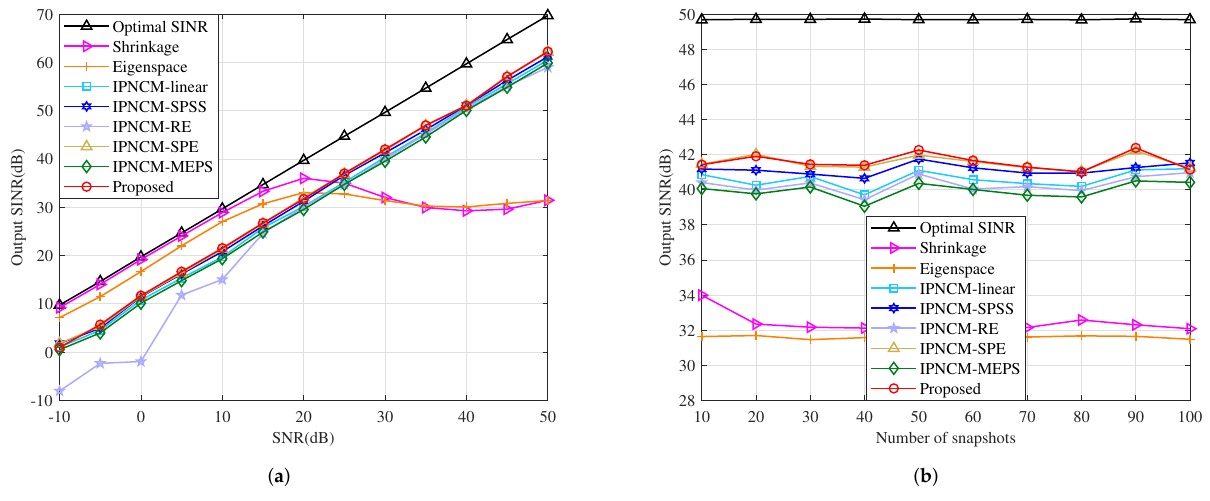
Figure 11. Output SINR in the case of array geometry error versus ( a ) input SNR, JNR = 30 dB, K = 50. ( b ) the number of snapshots, SNR = 30 dB, JNR = 30